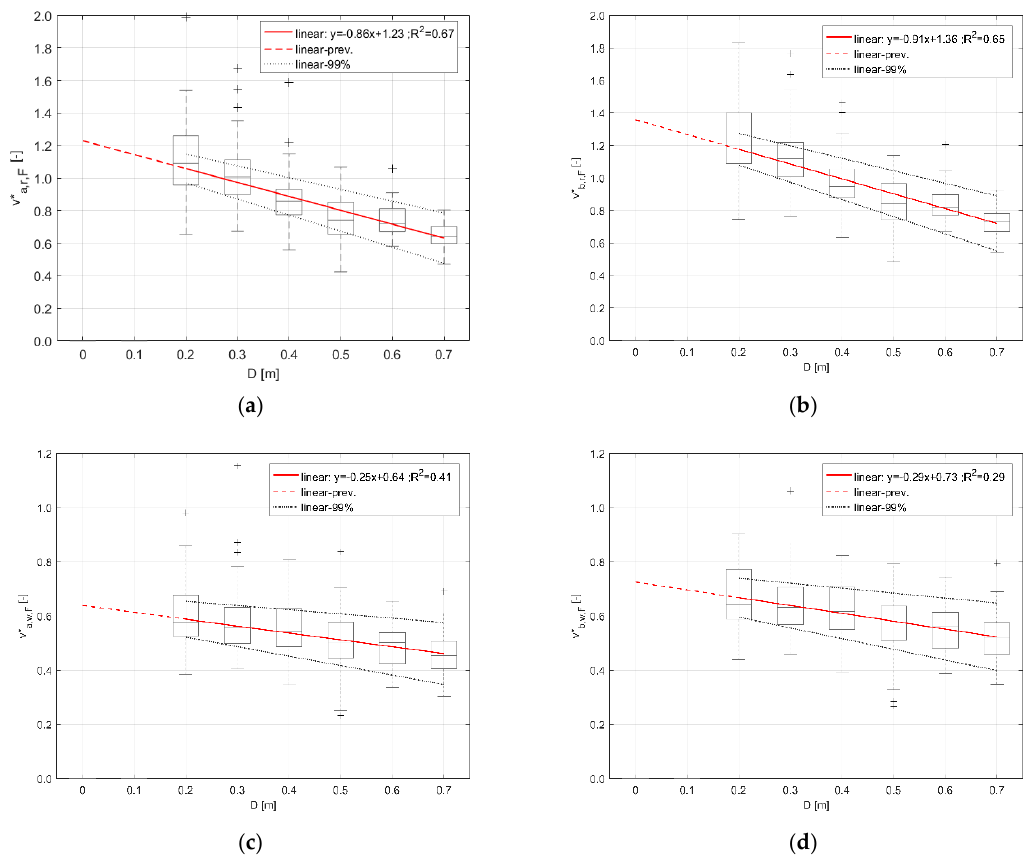
Figure 8. Normalized speed variation depending on D in respect to dry surface motion conditions, for the female sample: ( a ) for running conditions, according to the curve a [46]; ( b ) for running conditions, according to the curve b [43]; ( c ) for walking conditions, according to the curve a [46]; ( d ) for walking conditions, according to the curve b [43]. Linear regressions (dashed lines refer to expected values outside of the tested D range) and boundary conditions (99%) are shown. Outliers are shown in the boxplot representation (marked by “+”).